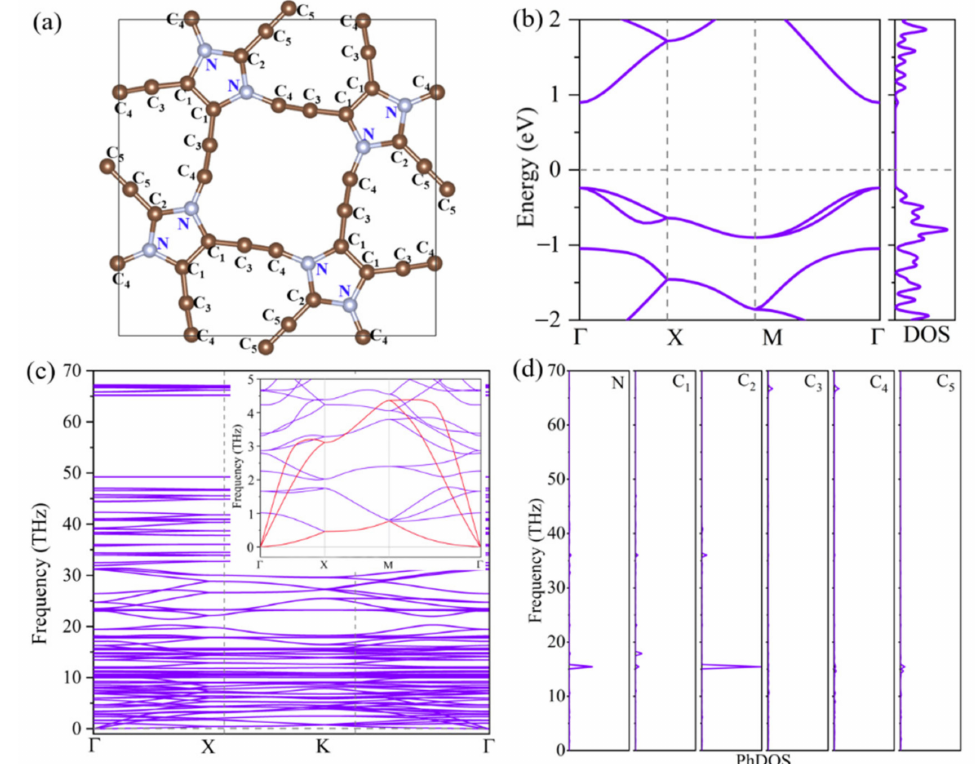
Figure 1. ( a ) Geometric structure, ( b ) electronic band structure, ( c ) phonon spectrum, and ( d ) partial phonon density of states (PhDOS) of